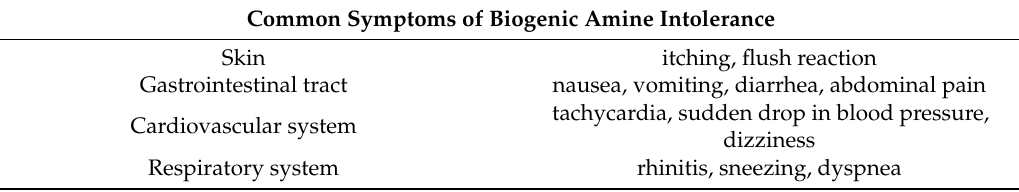
Table 2. Common symptoms of biogenic amine intolerance [1,35,36].